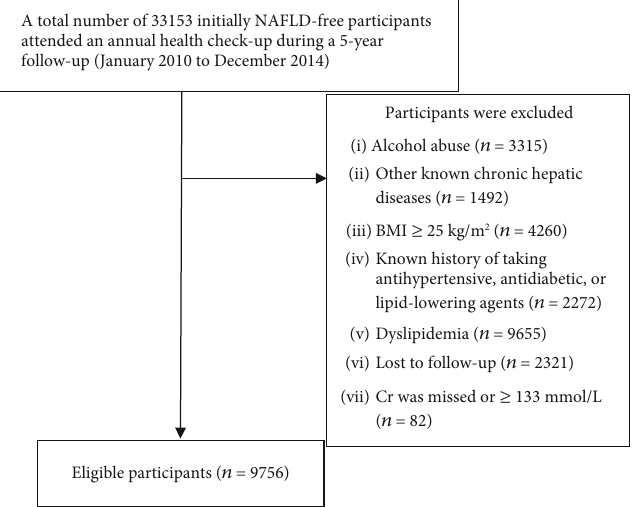
Figure 1: Flow chart. Abbreviations: NAFLD =nonalcoholic fatty liver disease; Cr=serum creatinine; n